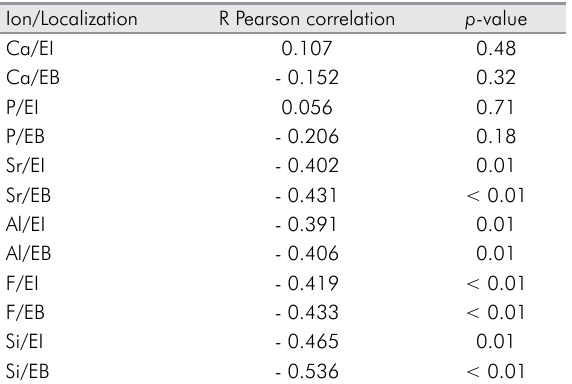
Table 5. Pearson correlation between white spot scores and ionic content in enamel